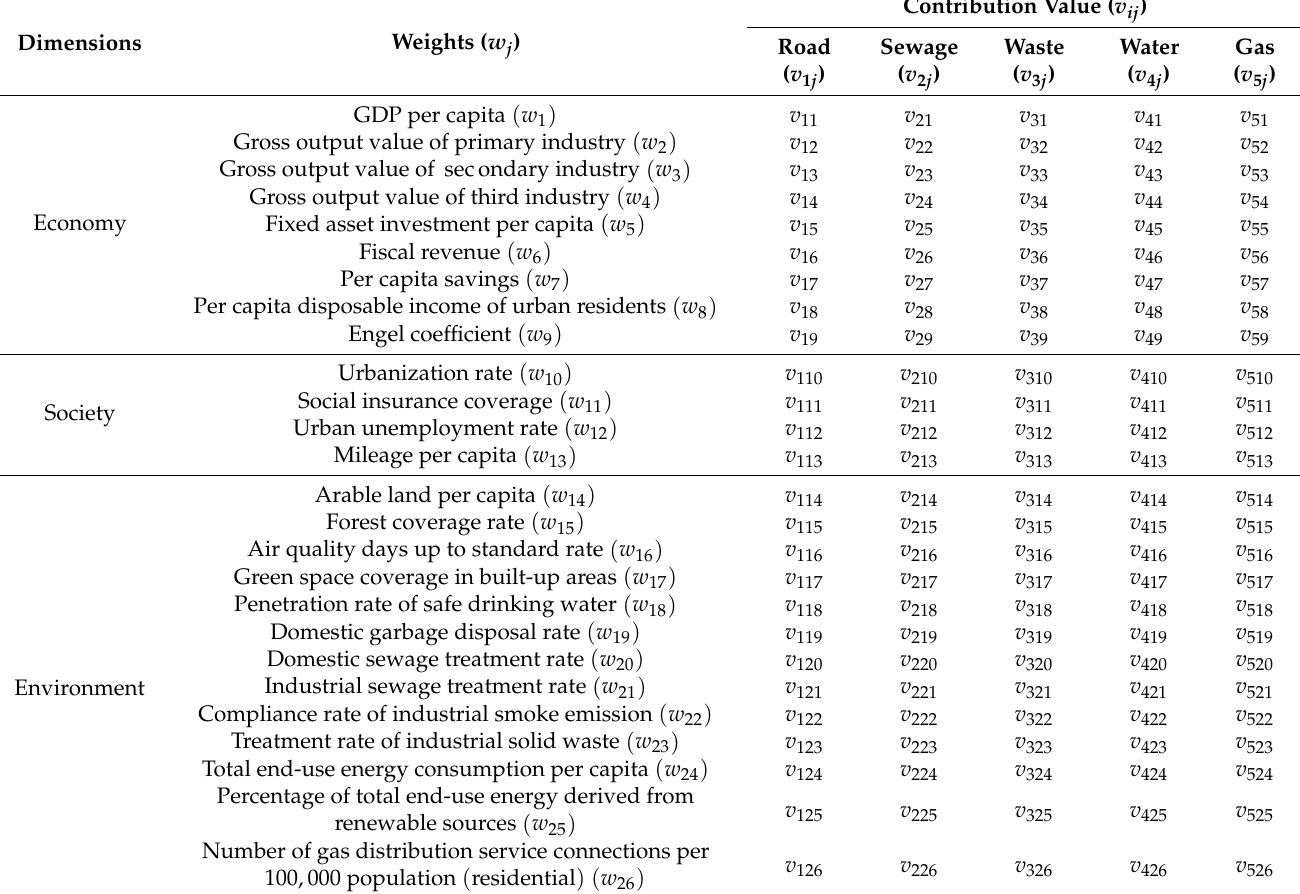
Table 6. Assessment system for sustainable contribution of infrastructure investment in